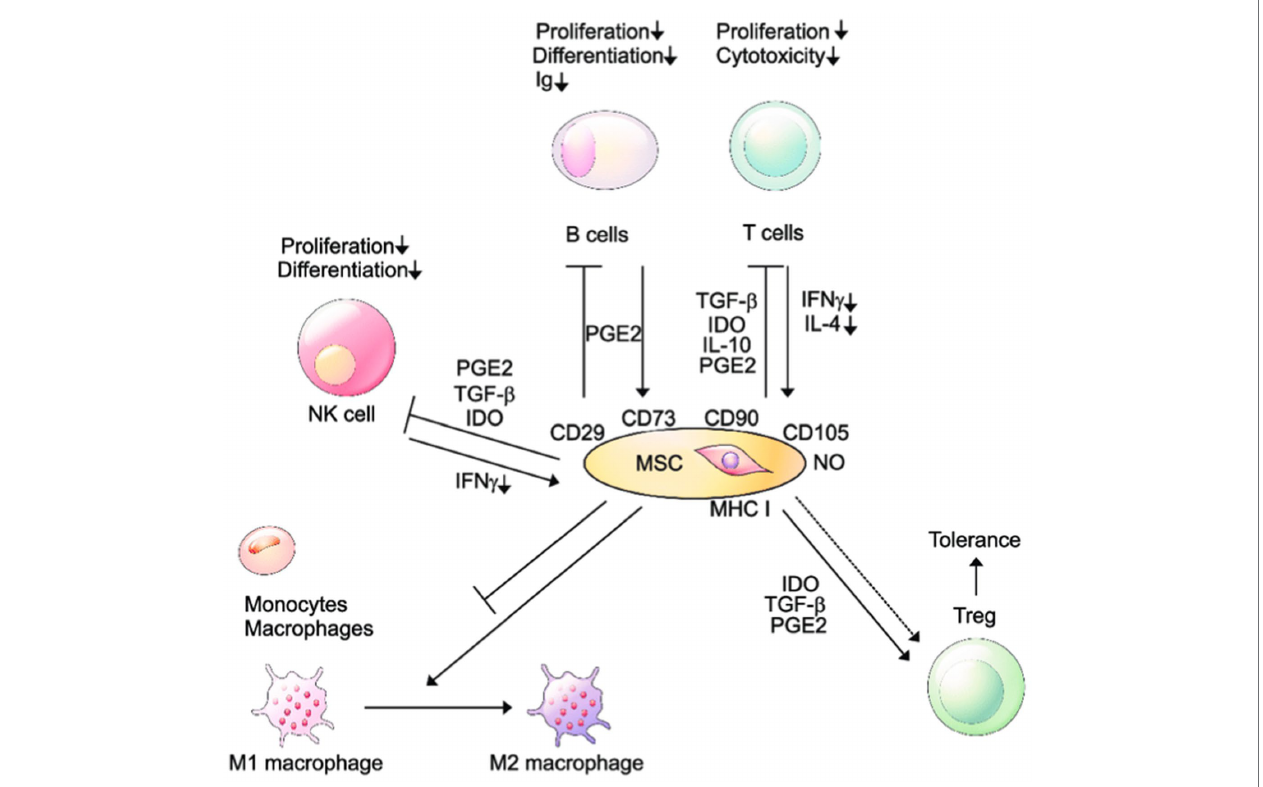
FIGURE 4 | Immunomodulation by MSCs. Ig, immunoglobulin; NK, natural killer; PGE, prostaglandin E; TGF, transforming growth factor; IDO, indoleamine 2,3-dioxygenase; IFN, interferon; IL, interleukin; MHC, major histocompatibility complex, NO, nitric oxide. (Adapted from Ref (Kang et al., 2020) under the terms of the Creative Commons Attribution License